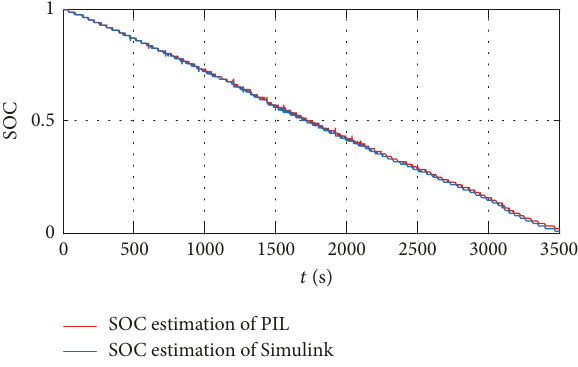
Figure 16: PIL test results of test